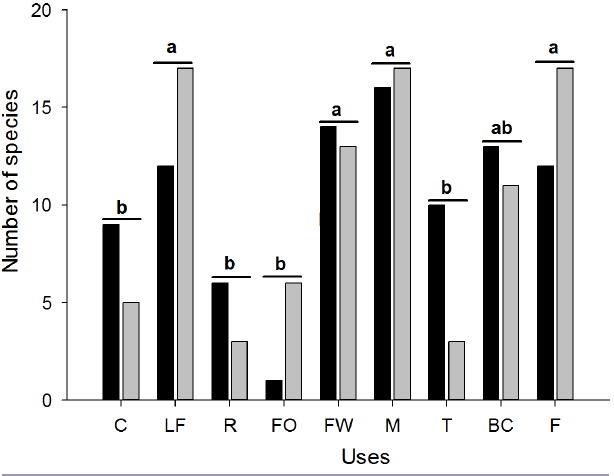
Fig. 5 . Plant species uses in the conserved (black bar) and secondary (gray bar) forests in El Tajín, Veracruz. C: crafts and tools, LF: live fencing, R: ritual and ornamental, FO: forage, FW: fuelwood, M: medicinal, T: timber, BC: building construction, and F: food. Letters indicate significant differences between uses ( P <